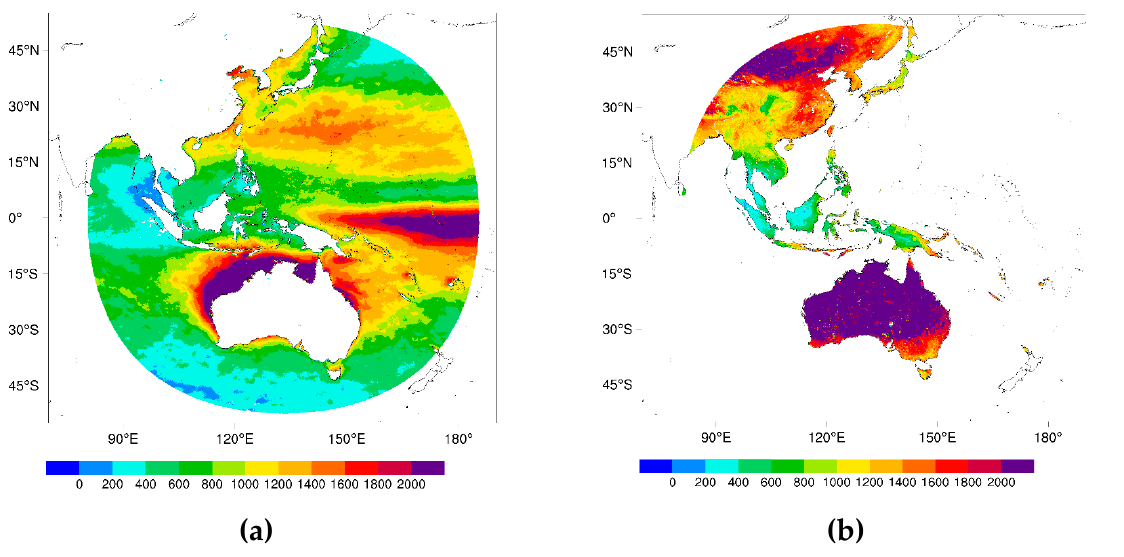
Figure 2. Spatial distribution of clear-sky pixel counts over ( a ) ocean and ( b ) land with satellite zenith angles less than 60° from June to November 2022.